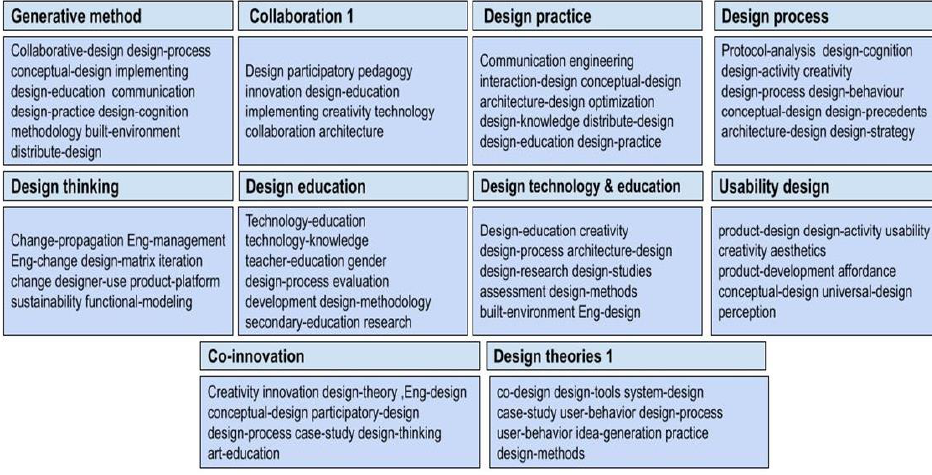
Figure 9. The ten clusters for the time-span 2012 – 2015.